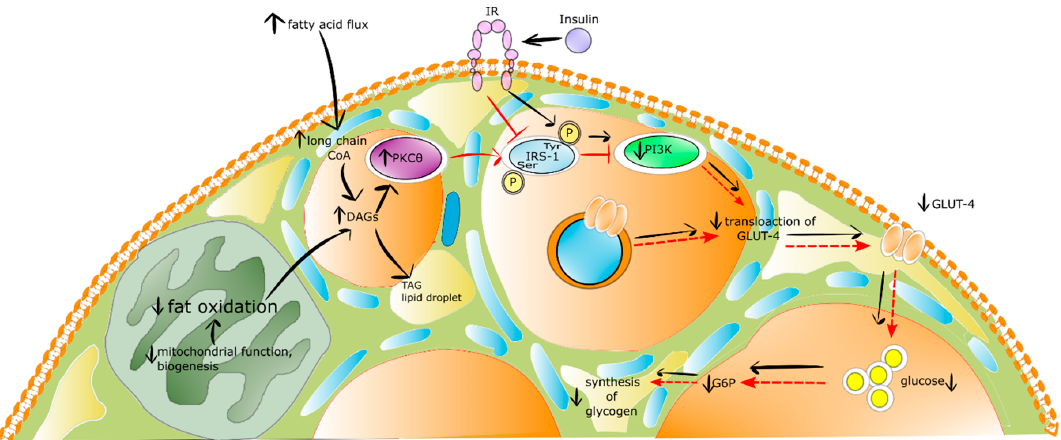
Figure 2. The insulin resistance mechanism in skeletal muscle. Stimulatory interactions are expressed by arrows and inhibition by T-bars, red color of arrow and T-bars denotes insulin resistance state, whereas black physiological state. ↓ denotes decrease ↑ denotes increase.